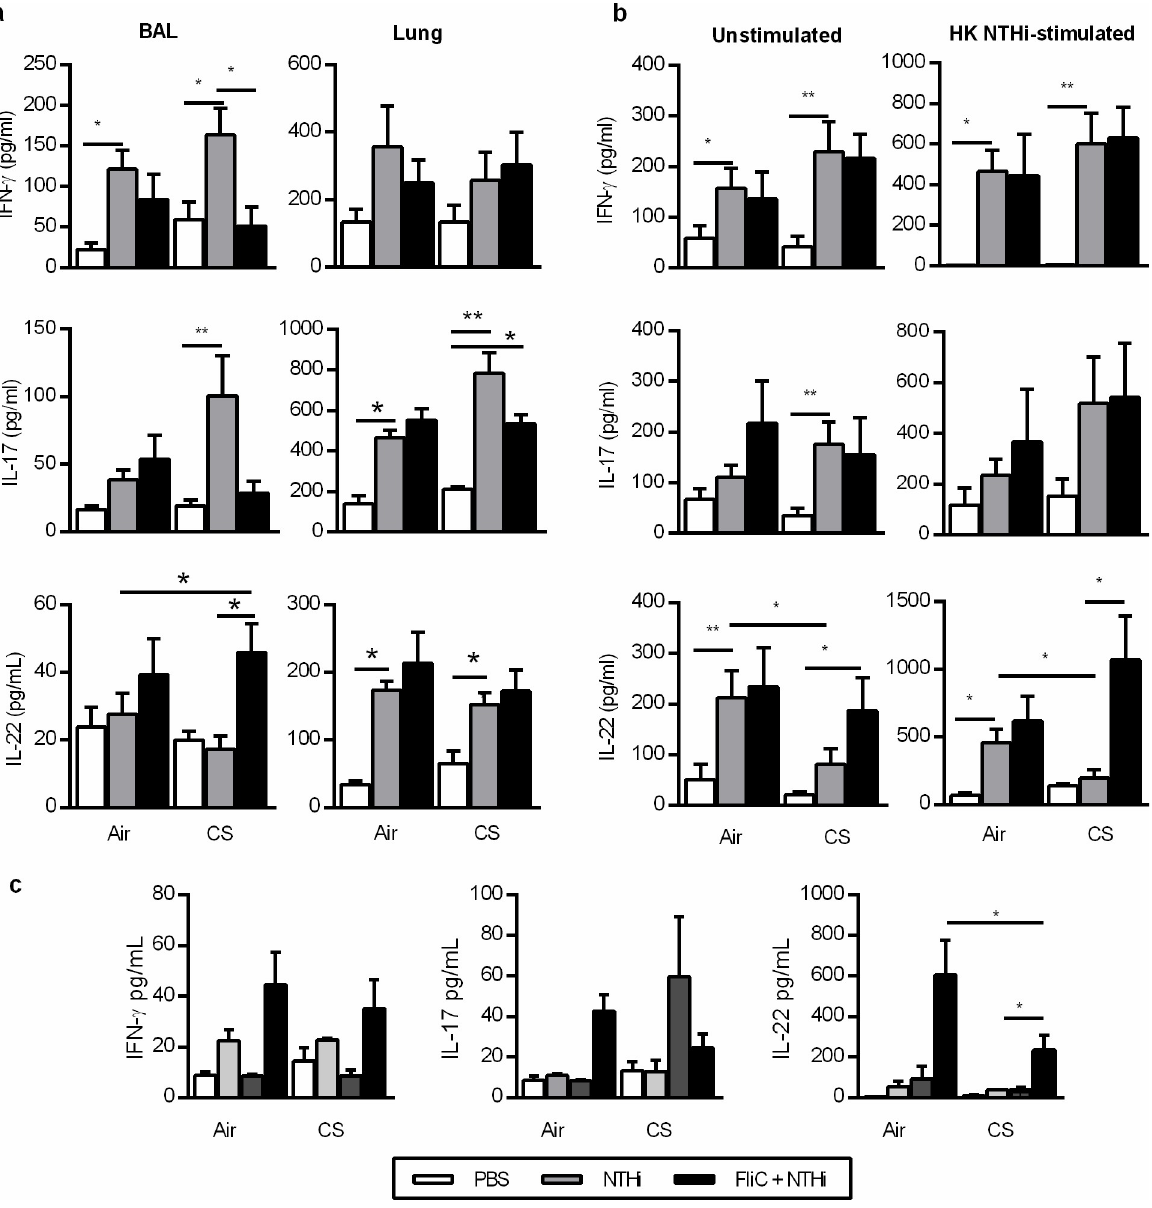
Fig 2. Flagellin limits NTHi induced inflammation in CS-exposed mice. (a) The concentrations of IFN- γ , IL-17 and IL-22 were analyzed in the BAL and the lungs of control and CS-exposed mice injected with PBS or FliC and infected or not with NTHi at 24h after NTHi challenge. (b) These cytokines were also evaluated in supernatants of lung cells either unstimulated or in vitro restimulated with heat-killes NTHi. (c) The concentrations of IFN- γ , IL-17 and IL-22 were measured in the sera at 24h after NTHi challenge. Three independent experiments have been performed with at least 3 mice in each group. The data are expressed as mean ± SEM. � : p < 0.05, �� : p < 0.01, ��� : p < 0.001.